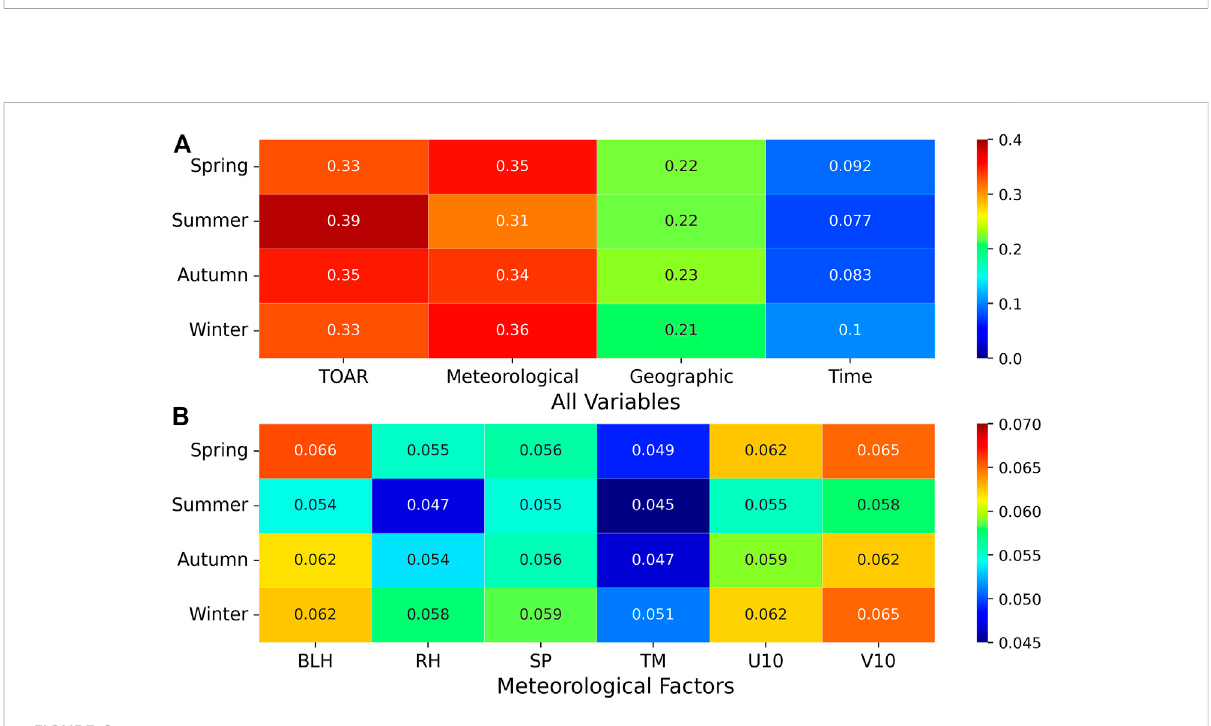
FIGURE 6 (A) The feature importance of all variables in different seasonal models, and (B) the feature importance of meteorological